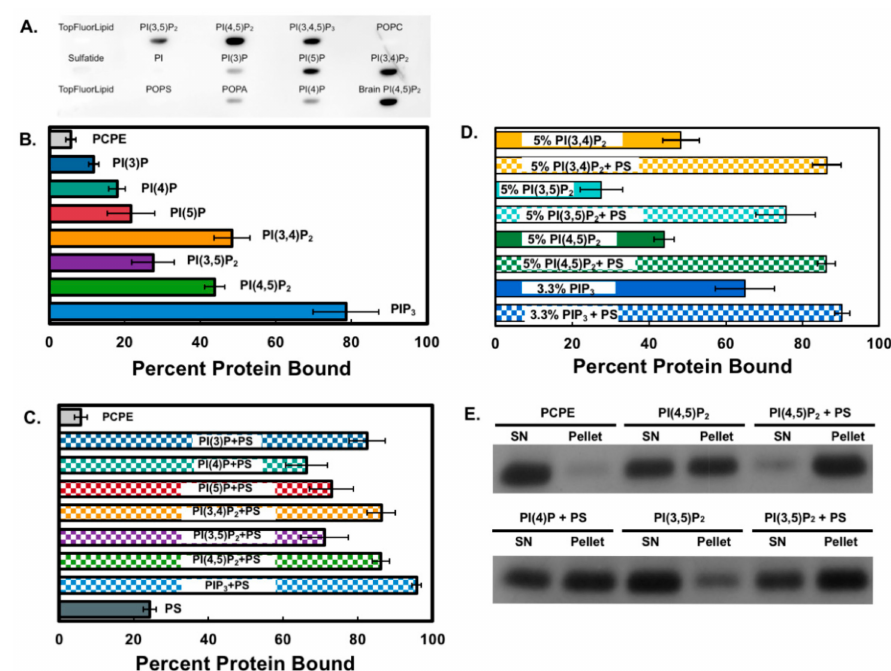
Figure 1. The SMAD ubiquitination regulatory factor 1 (Smurf1) C2 domain binds to